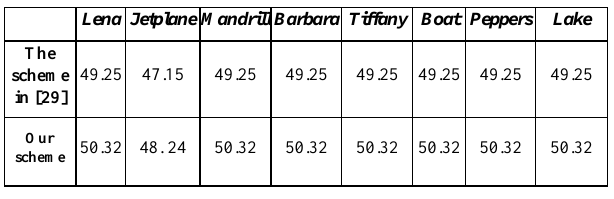
Table 5. Comparison of scaling detection